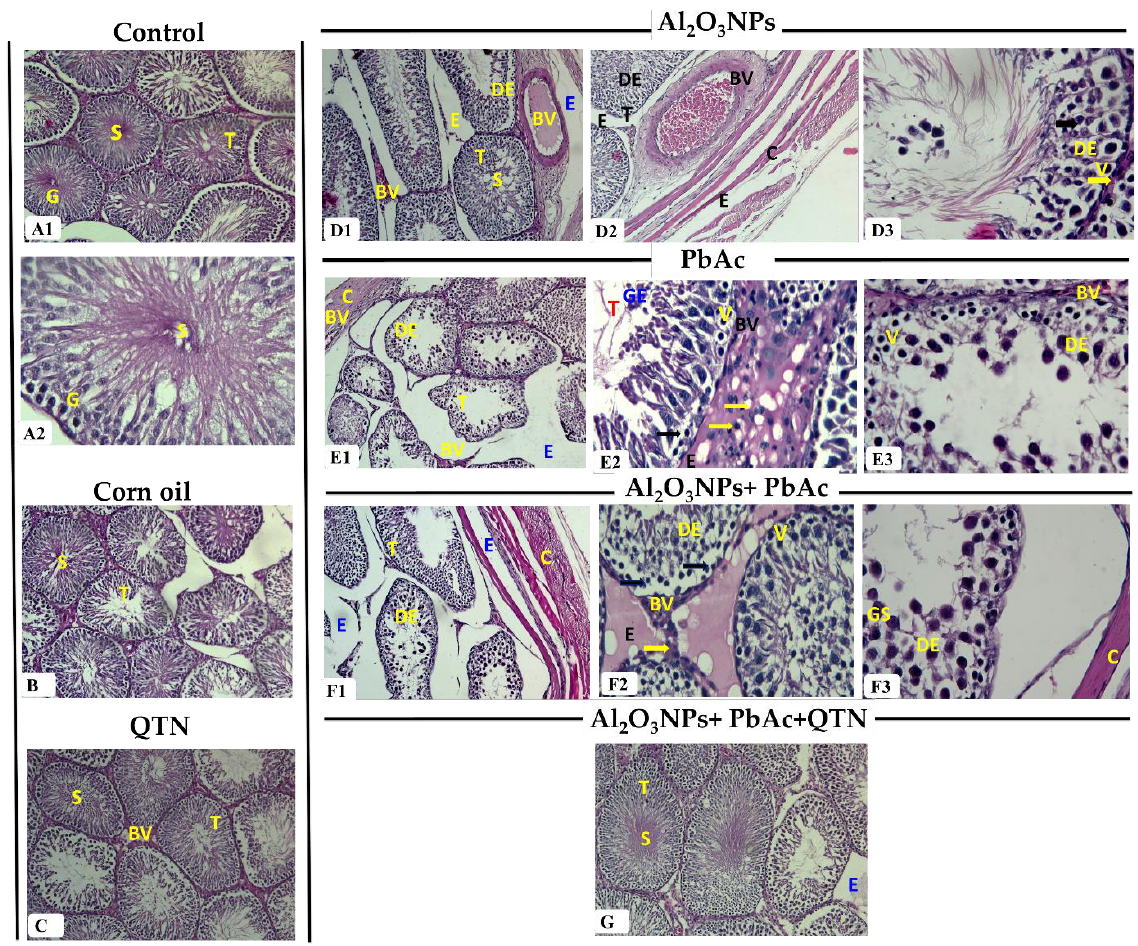
Figure 2. ( A1 ) Testis of control group showing normal structure. It consisted of seminiferous tubules (T) lined by stratified germinal epithelium (G) and lumen filled with spermatozoa (S) (H&E, × 100). ( A2 ) Testis of the control group showing stratified germinal epithelium (G) lined seminiferous tubules (T) and spermatozoa (S) in the tubular lumen (H&E, × 400). ( B ) Testis of corn oil-treated group showing normal seminiferous tubules (T) lined by several layers of germinal epithelium (G) and spermatozoa (S) in the lumen (H&E, × 100). ( C ) Testis of QTN-treated group showing several rows of germinal epithelium (G) lined seminiferous tubules (T) and spermatozoa (S) in the lumen (H&E, × 100). ( D1 ) Testis of Al 2 O 3 NPs-exposed group showing atrophied seminiferous tubules (T) with few spermatozoa (S) in the lumen, disorganized epithelium (DE), severe congestion of the interstitial and sub-capsular blood vessels (BV) and edema (E) (H&E, × 100). ( D2 ) Testis of Al 2 O 3 NPs-exposed group showing disorganized epithelium (DE) in the seminiferous tubules (T), interstitial and capsular edema (E), severe congestion of the thickened wall sub-capsular blood vessel (BV) as well as a thick capsule (C) (H&E, × 100). ( D3 ) Testis of Al 2 O 3 NPs-exposed group showing epithelial disorganization (DE), sloughing of germinal epithelium, necrotic epithelium, and darkly stained pyknotic nuclei ( Black arrow ), the vacuolated epithelium (V), thickened basement membrane ( Yellow arrow ) and few spermatozoa (S) in lumen (H&E, × 400). ( E1 ) Testis of PbAc-exposed group showing atrophied seminiferous tubules (T) with a corrugated outline, sloughed germinal epithelium, the disorganized epithelium (DE), severe congestion of interstitial and sub-capsular blood vessels (BV), edema (E), and thickened capsule (C) (H&E, × 100). ( E2 ) Testis of PbAc-exposed group showing sloughed germinal epithelium (GE) within seminiferous tubules (T), necrotic with darkly stained pyknotic nuclei ( Arrow ) and vacuolated (V) germinal epithelium, congestion of interstitial blood vessels (BV), edema (E), and interstitial inflammatory cell infiltrations (yellow arrow) (H&E, × 400). ( E3 ) Testis of